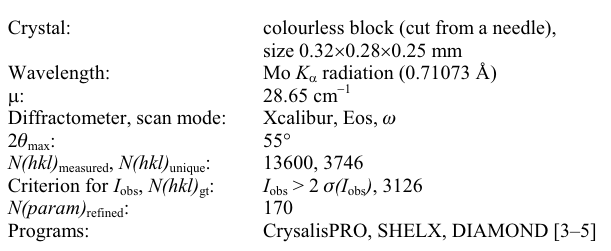
Table 1. Data collection and